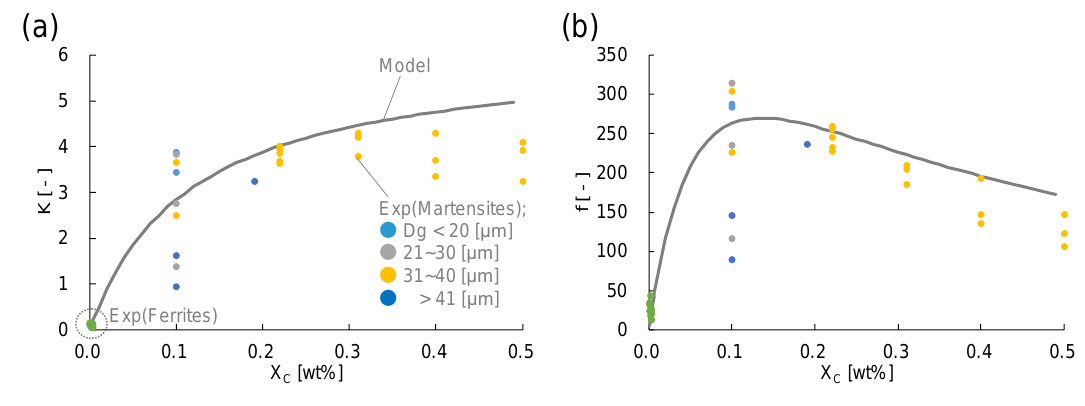
Figure 8. Effectiveness of X C on: ( a ) K ; and ( b ) f